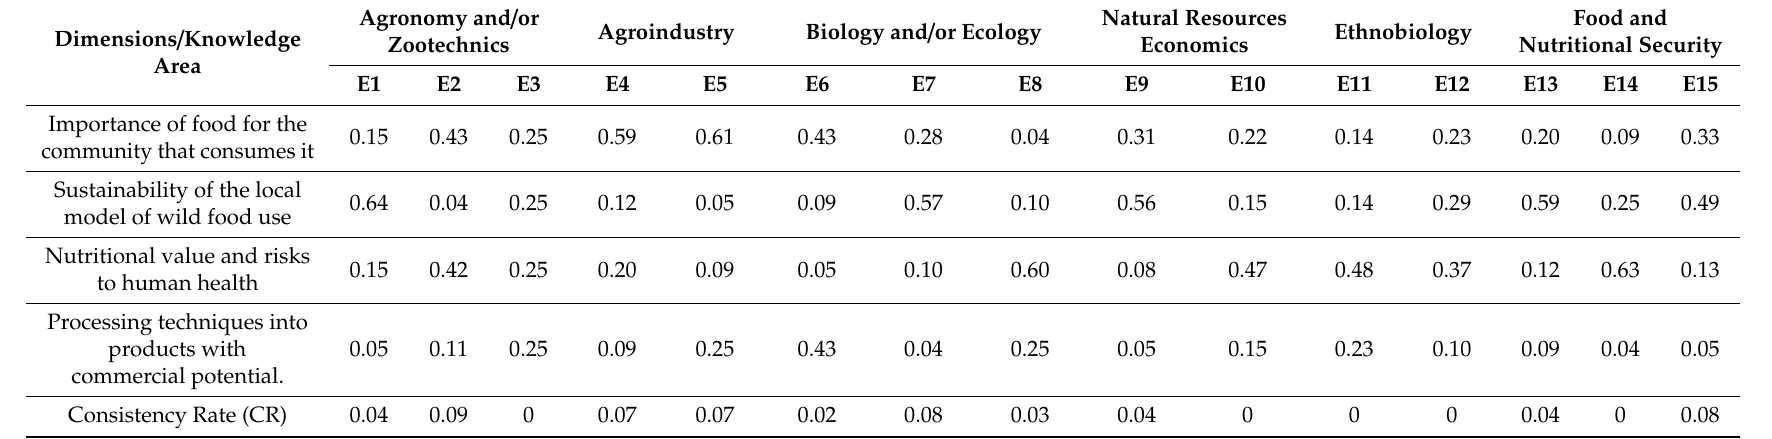
Natural Resources Food and Ethnobiology Economics Nutritional